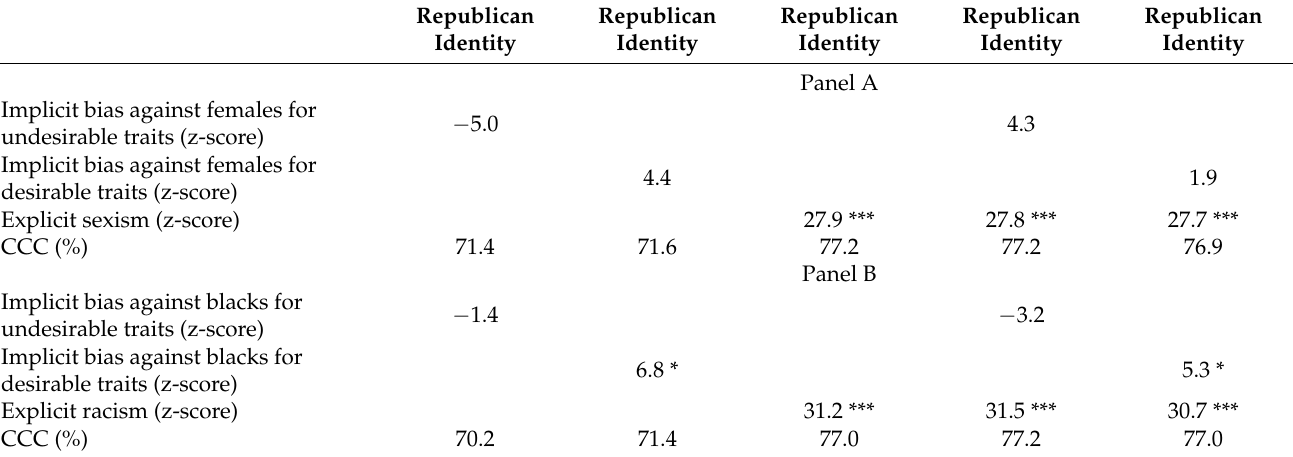
Table 3. Logit models comparing the effects of implicit bias and explicit prejudice on Republican identity. Republican Republican Republican Republican Identity Identity Identity Identity